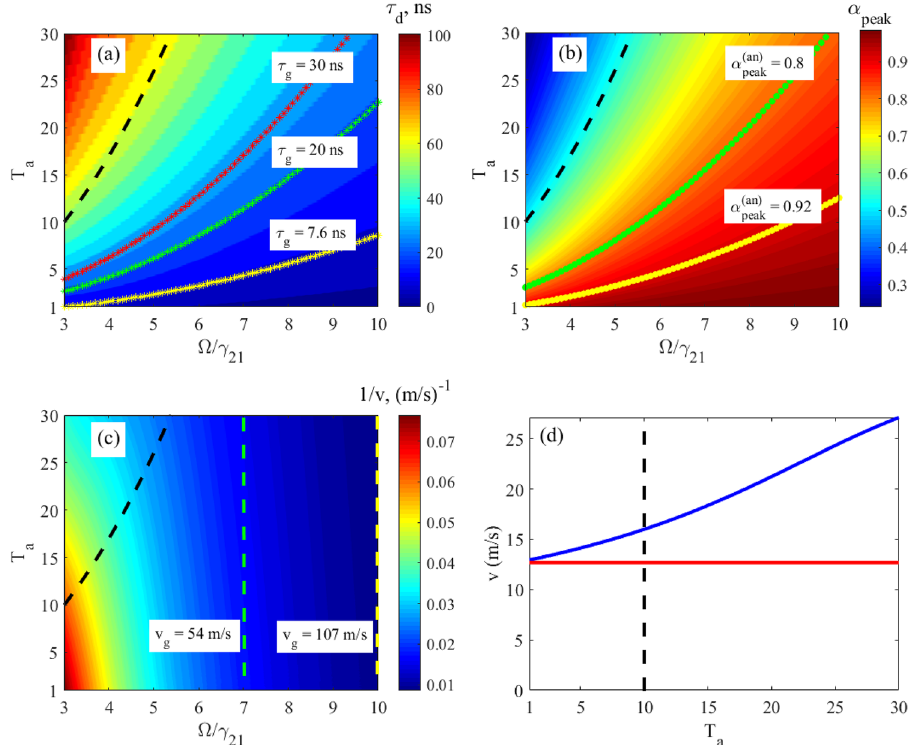
Figure 4. Characteristics of the relatively broadband Gaussian single-photon pulse (Eq. (36), where � G γ 21 ) at the output from the vibrating absorber. (a) The moment (in nanoseconds) of formation of the = pulse maximum, τ d , according to Eq. (34), (b) the normalized peak intensity of the transmitted pulse, α peak , v , according to Eq. (35), as functions of the according to Eq. (33), and (c) the reciprocal propagation velocity, 1 γ 21 , and the resonant optical depth, T a (see (17)) of the absorber normalized absorber vibration frequency, � (cid:31) plotted using numerical integration of Eq. (33). (d) The propagation velocity, blue line, of the same wave packet (cid:31) 3 , calculated γ 21 as a function of the resonant optical depth, T a , at the fixed absorber vibration frequency, � = using Eq. (35) and numerical integration of Eq. (33). Yellow, green and red stars in ( a ) mark the lines of constant (cid:31) 7.6 ns , 20 ns , and 30 ns , respectively, estimated for a narrowband pulse, � group delay, τ g G ≪ γ 21 , by Eqs. = (40), (21). Yellow and green circles in ( b ) mark the lines of constant peak intensity of the transmitted pulse, 0.92 and 0.8 , respectively, estimated for a narrowband pulse, � α ( an ) G ≪ γ 21 , by Eqs. (43), (18). Green and peak = 54 m/s , and v 107 m/s , respectively, of the yellow dashed lines in ( c ) correspond to the group velocities, v g g = = γ 21 estimated by Eq. (19). On all panels, the black dashed lines mark the boundary narrowband pulse, � G ≪ 1 (see Eq. (41)), approaching to which from the right and bottom in ( a )–( c ) and from the left T + in ( d ) invalidates the group velocity model. Other parameters of the absorber are presented after Eq.